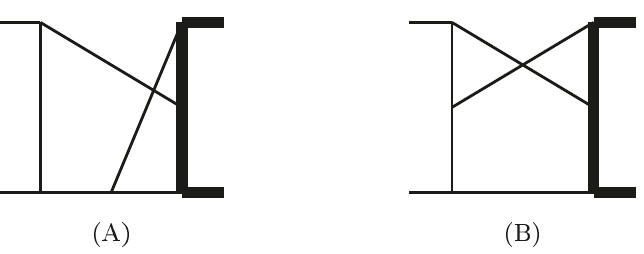
Figure 1 . Seven-denominator topologies. Thin lines represent massless external particles and internal propagators, while thick lines represent massive external particles and internal